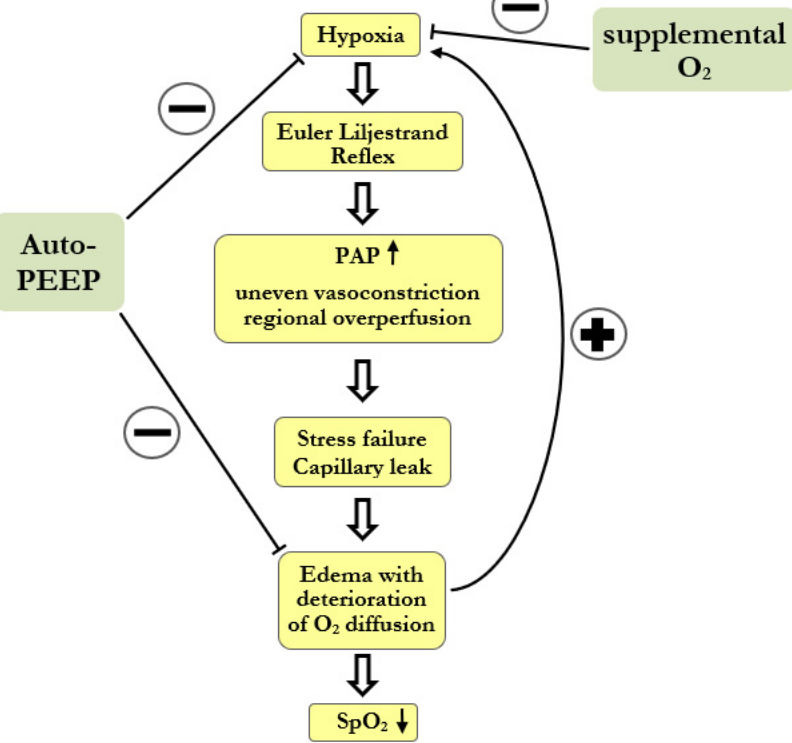
Figure 3: How hypoxia induces HAPE, modified from West et al. [37] considering Luks et al. [17] with the points of attack Figure 2. The pulmonal edema aggravates hypoxia due to enlarged alveolar-capillary diffusion distance.